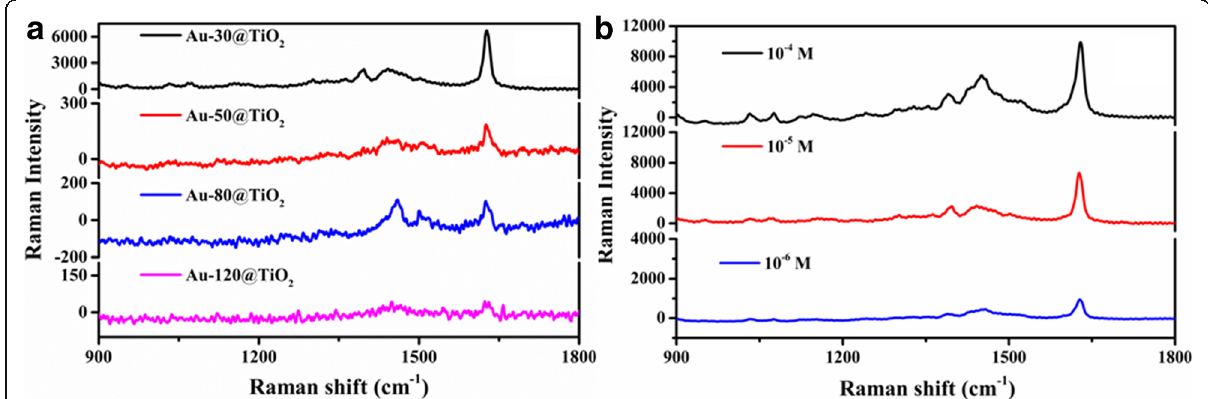
Fig. 8 a The SERS spectra of 1.0 × 10 − 5 M MB solution collected on the substrates with different Au-x@TiO 2 . b The SERS spectra of MB with differ- ent concentrations collected on the Au-30@TiO 2